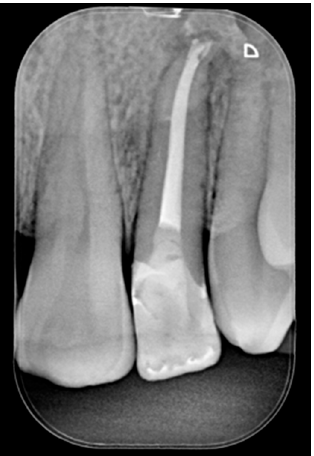
Figure 29. Six-months post-operative x-ray. Reprinted from Restauri diretti nei settori anteriori, G. Paolone, S. Scolavino, © 2021, with permission from Quintessence Publishing Italy.